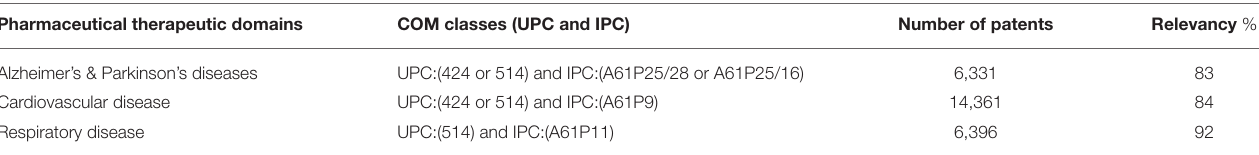
TABLE 2 | Pharmaceutical therapeutic technological domains with their respective UPC and IPC classes used for obtaining patents between 1976 and 2015, using the COM procedure. Pharmaceutical therapeutic domains